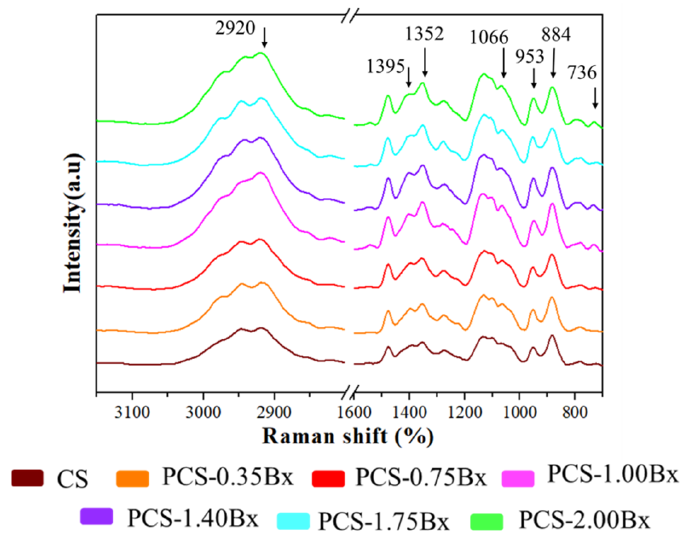
Figure 4. Evolution of the Raman spectra for cassava starch biopolymer films with different borax content.